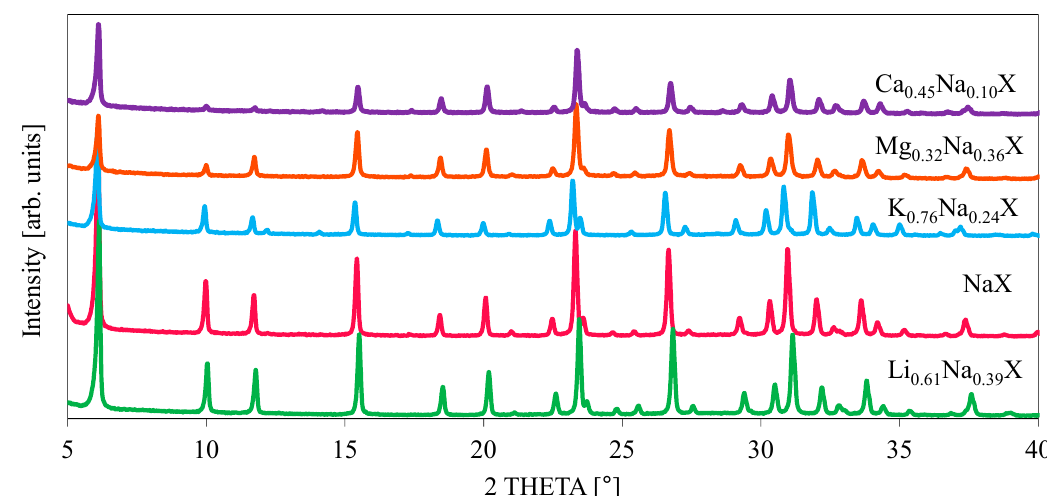
Figure 4. Pore size distributions of samples containing the monovalent ( A ) and divalent cations ( B ), calculated from CO 2 isotherms at 273 K.